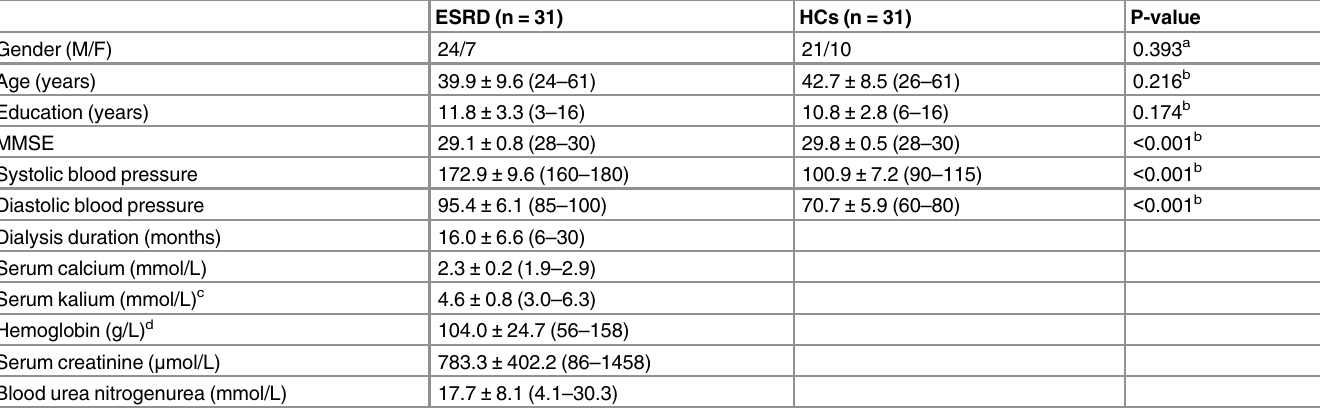
Table 1. Demographics and clinical characteristics of all